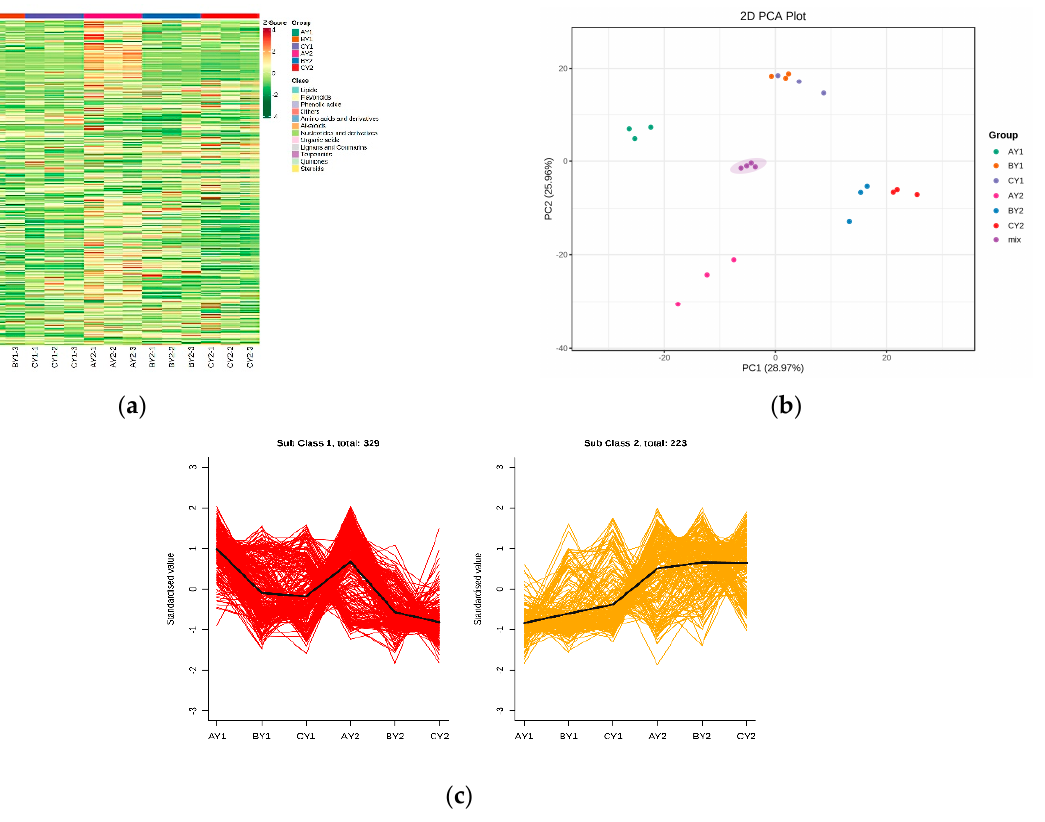
Figure 3. Analysis of metabolome differences in quinoa lines under low-temperature stress: ( a ) overall cluster plot of samples; ( b ) PCA plot of metabolites; ( c ) K-means plot of differential metabolites. Table 2. Top 10 DAMs in freezing vs.